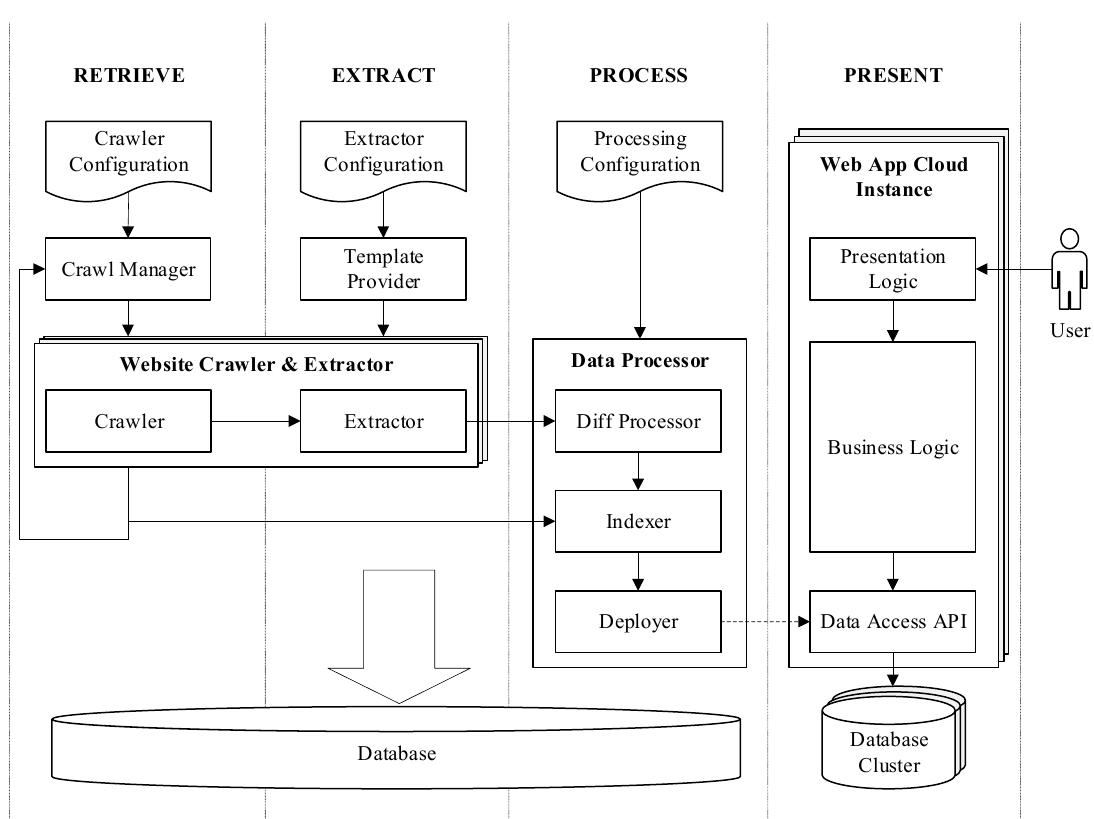
Figure 1. Overview of the proposed solution architecture and the information flow between the main components. For the first three actions (i.e., retrieve, extract, process) the components are on a local server and share the same database. For the last action (i.e., present), the components are deployed on a cloud platform.